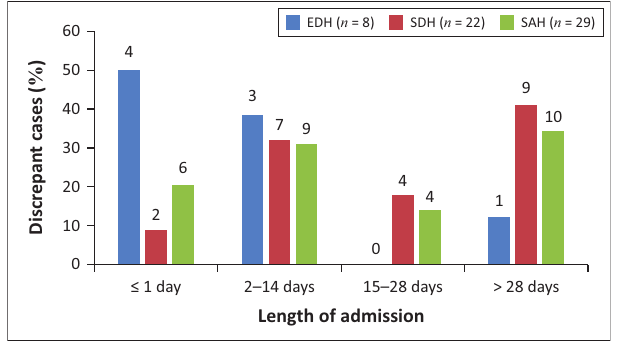
FIGURE 2: Discrepancies and length of admission, South Africa, 2014–2016.